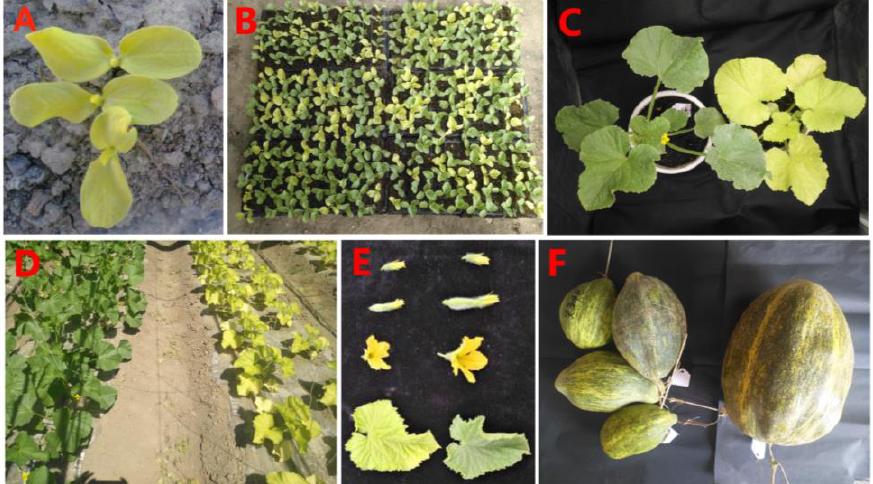
Figure 1. The phenotypic characteristics of yellow-green mutants (MT) and wild-type (WT) plants of Hami melon. ( A ) cotyledon stage of MT; ( B ) F2 progenies; ( C ) seedling stage of MT (right) and WT (left); ( D ) The field performance of MT (right) and WT (left) plants; ( E ) reproductive organs of MT (left) and WT (right); ( F ) Fruits of MT (left) and WT (right)